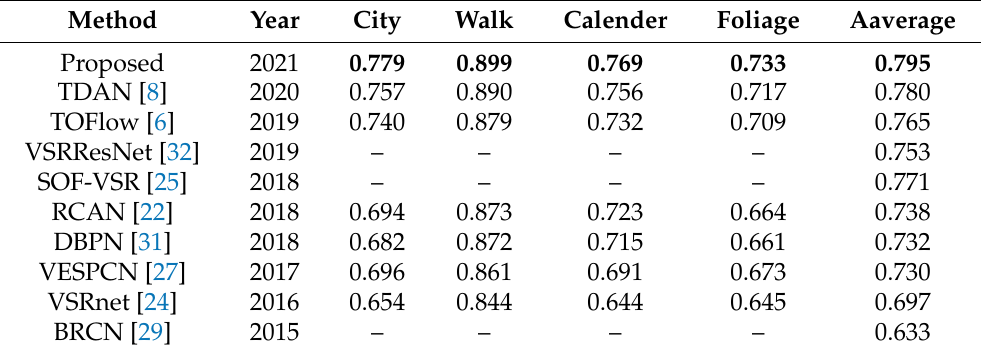
Table 3. Comparison of SSIM with state-of-the-art methods on Vid4 dataset with scaling factor of 4. The best methods results are shown in boldface.